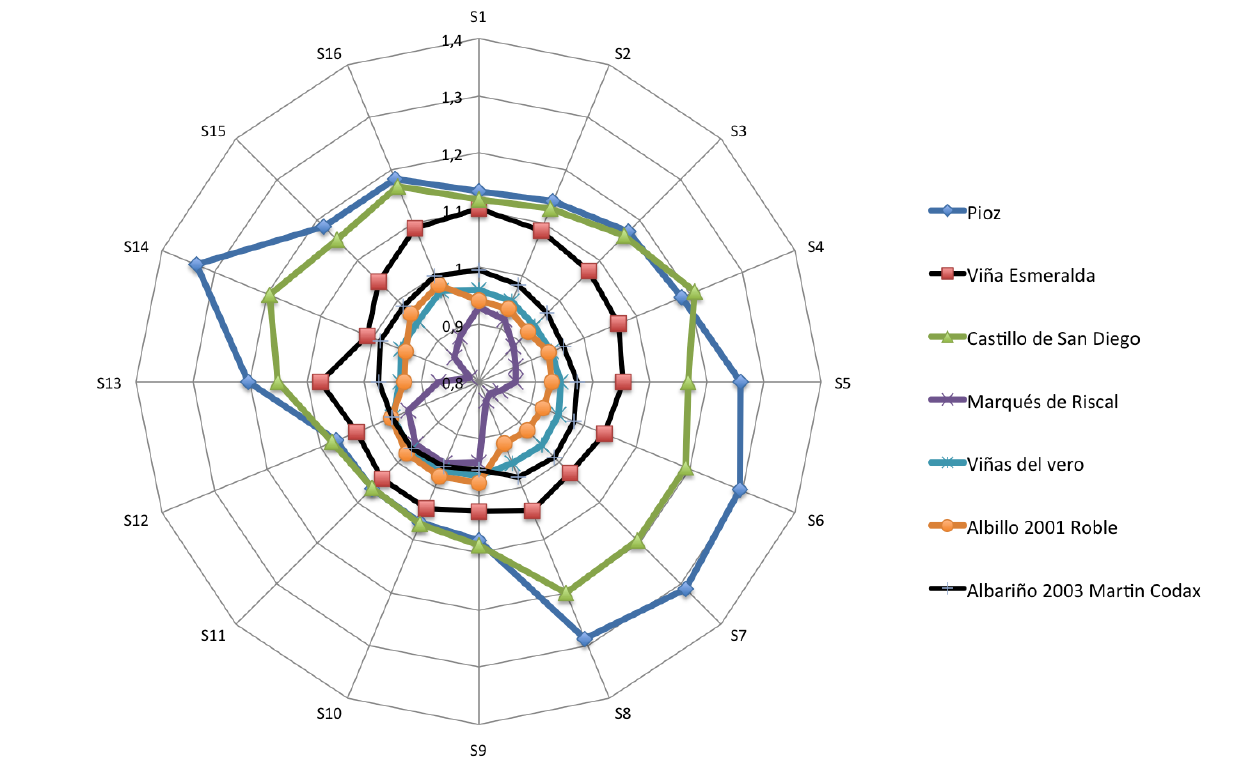
Figure 4. Polar plots of the variation in sensor resistance for the white